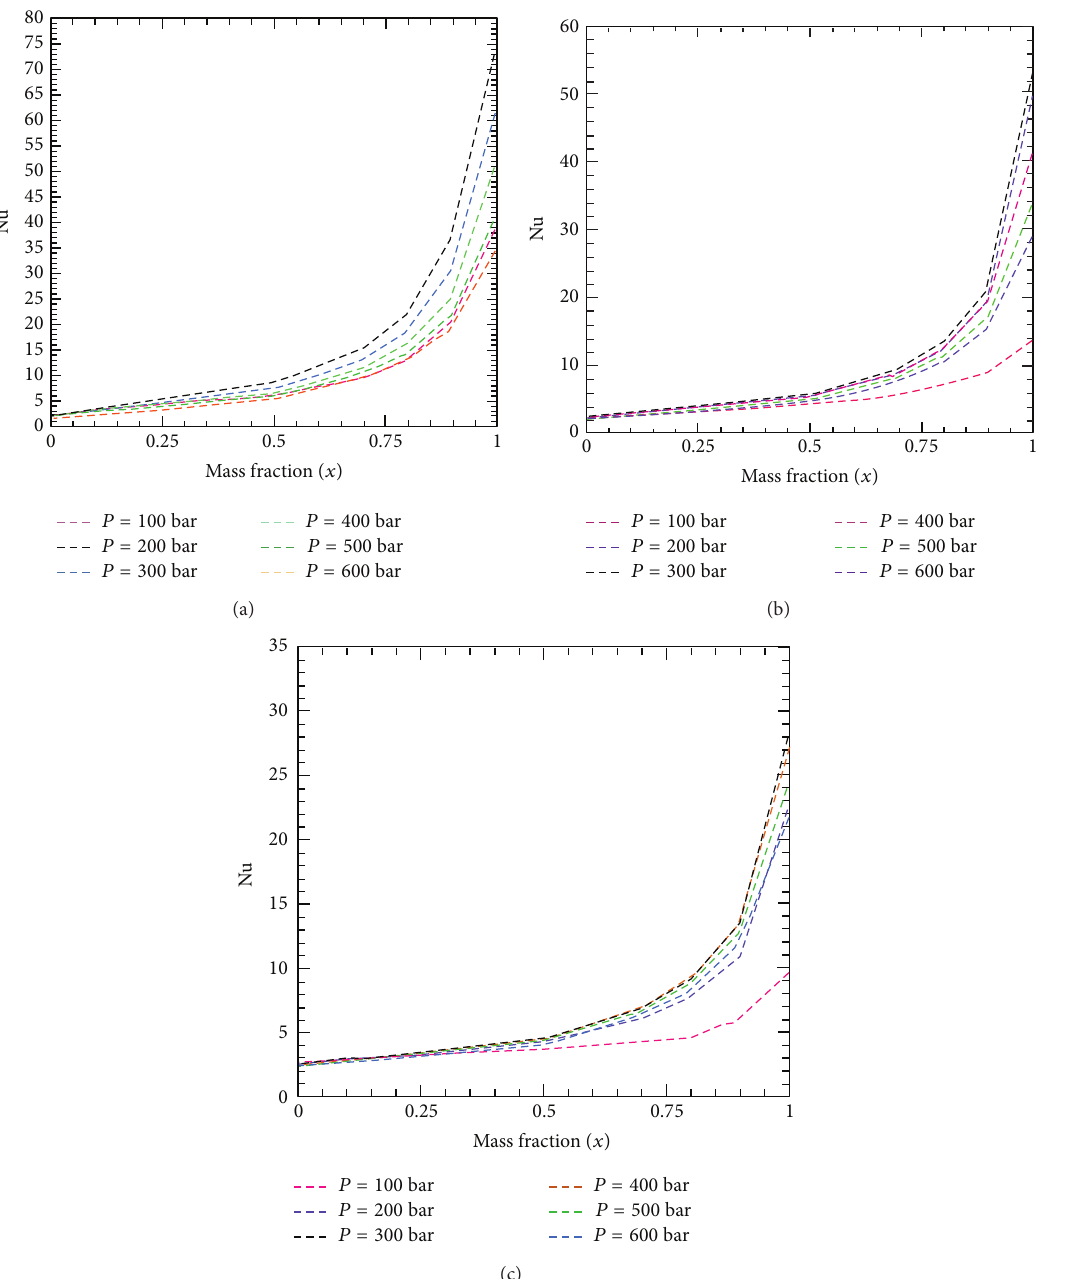
Figure 4: Nusselt number versus CO 2 mass fraction for different reservoir pressures and temperature combinations: (a) 𝑇 ℎ = 416 K; 𝑇 𝑐 = = 466 K; 𝑇 = 381 K, and (c) 𝑇 = 516 K; 𝑇 = 431 331 K, (b) 𝑇 ℎ 𝑐 ℎ 𝑐